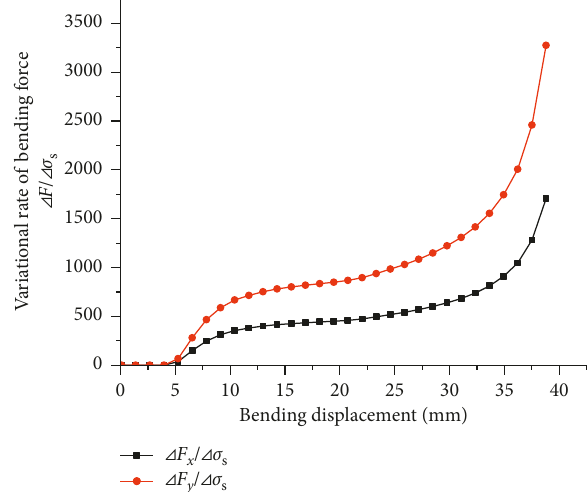
Figure 12: Effect of the rate yield strength on the bending